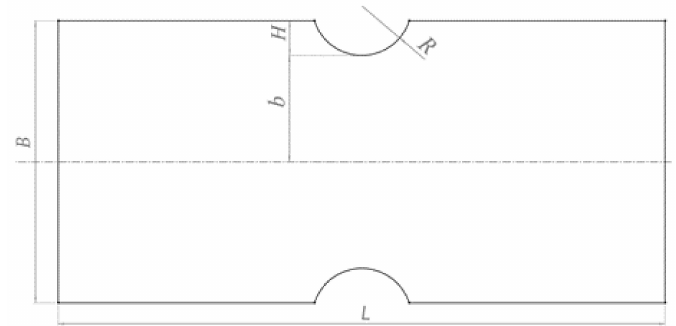
Figure 2. A plate with two side notches.